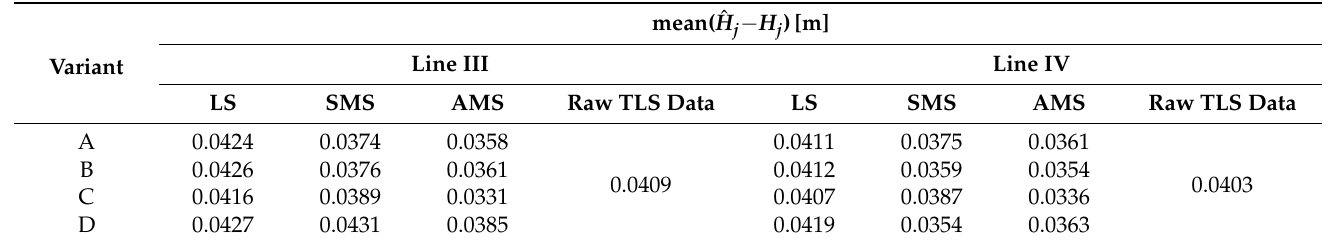
(cid:16) (cid:17) ˆ H − H for lines III and IV. j j